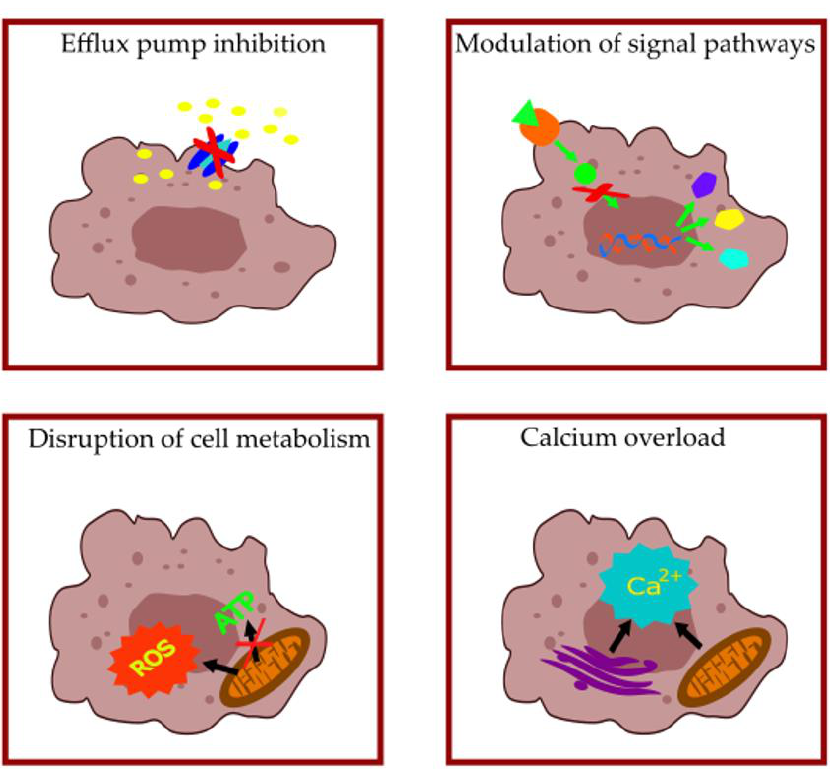
Figure 5. Main mechanisms of anticancer activity of selective serotonin reuptake inhibitors (SSRIs), tricyclic antidepressants (TCAs), and phenothiazine-type antipsychotics.